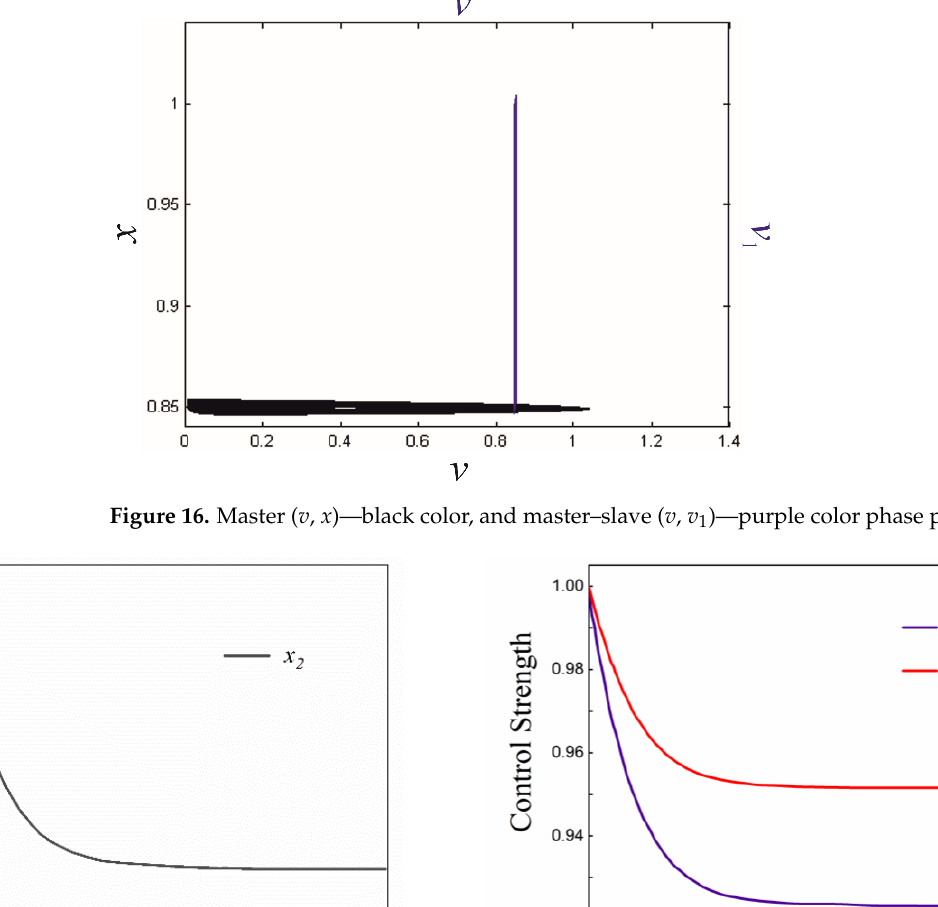
Figure 15. Master ( z , v )—black color, and master–slave ( z , z 1 )—green color phase portraits.